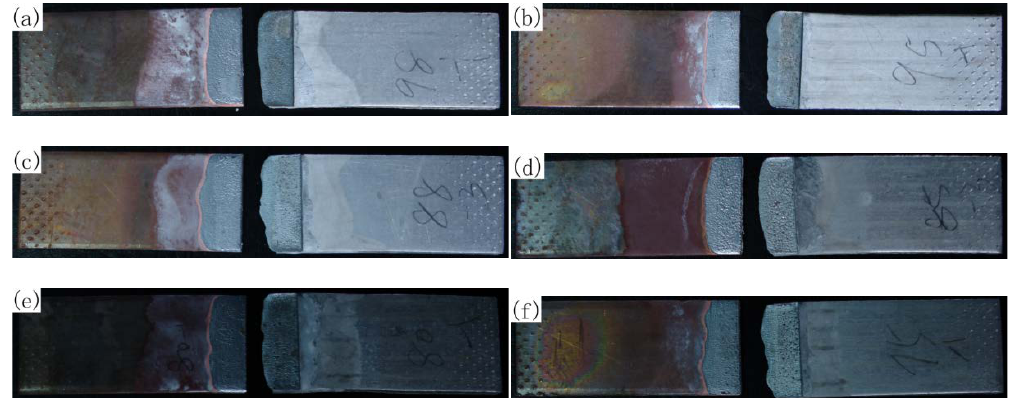
Figure 5. Macro fracture surfaces of 1035 Al / Cu joint brazed by ( a ) Zn-2Al; ( b ) Zn-5Al; ( c ) Zn-12Al; ( d ) Zn-15Al; ( e ) Zn-20Al; and ( f ) Zn-25Al.